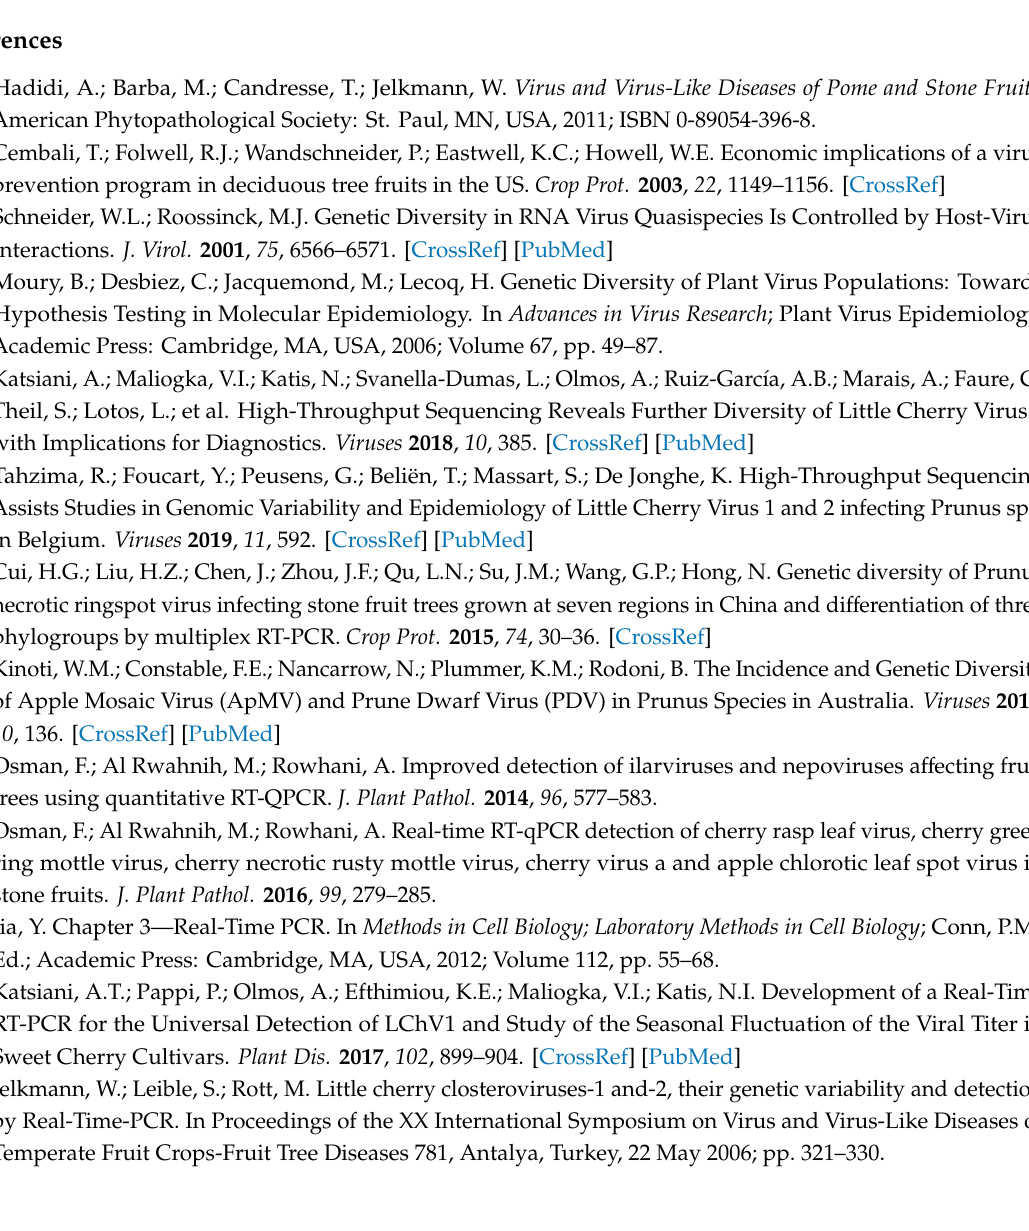
273 / s1. Figure S1: Alignments of genomic regions present in di ff erent Prunus-infecting viruses and amplified by the real-time RT-PCR assays. Figure S2: Amplification plot and standard curve generated from new / updated real-time RT-PCR assays. Table S1: Prunus samples analyzed by HTS and included in the initial validation of assays. Table S2: Information of samples collected at the NCGR and tested positive for viruses during the